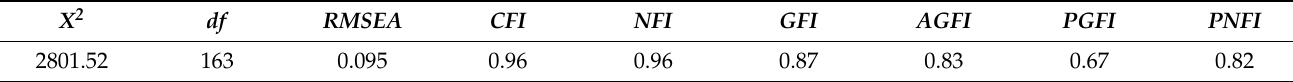
Table 1. Goodness of fit statistics of structural models.